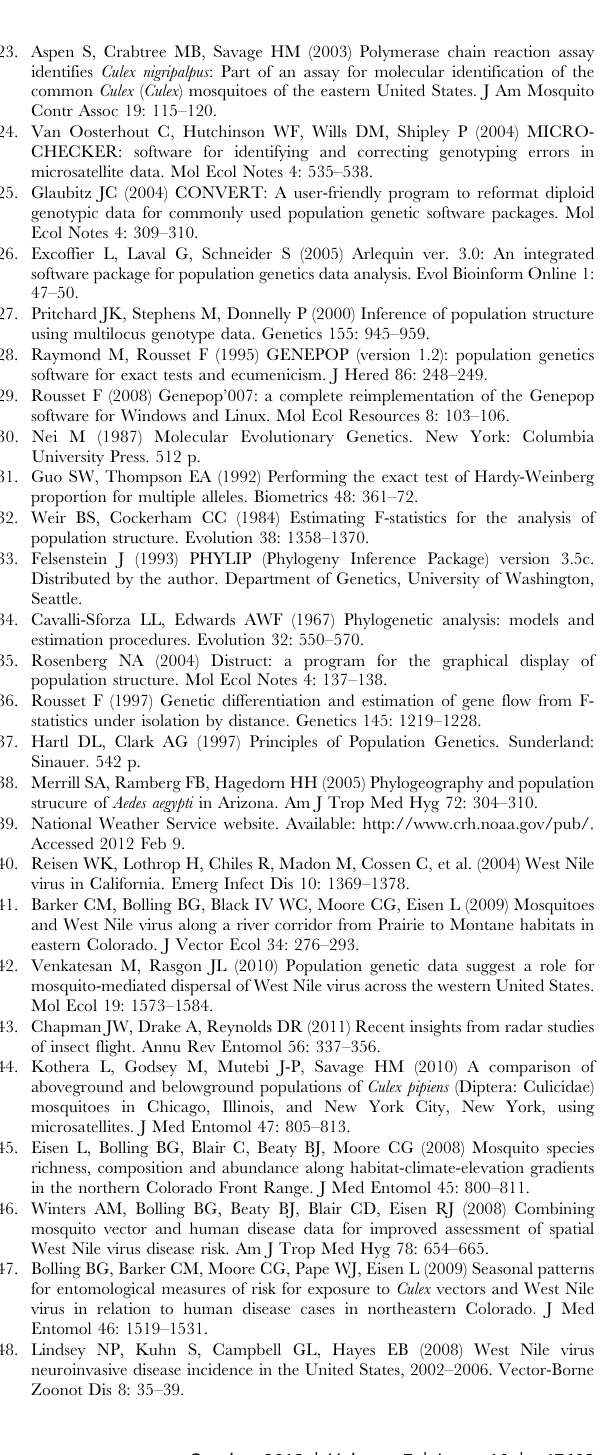
Table S2 Pairwise F ST values between pairs of Culex pipiens complex populations in